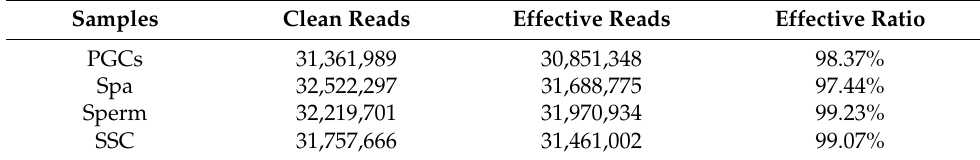
Table 1. The Q20 value of the base mass was greater than 90%. The raw reads used were preprocessed using FASTX. The effective reads results are shown in Table 1. Table 1. Information on small RNA sequencing